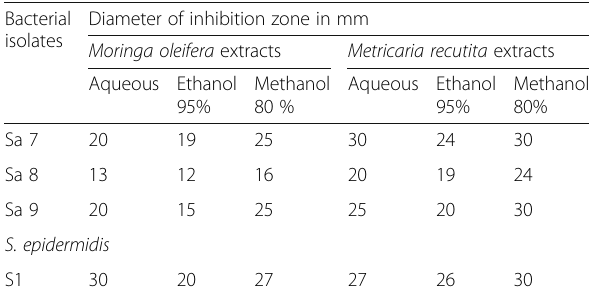
Table 5 Antimicrobial activity (in mm) of plant extracts against tested bacterial isolates (Continued) Bacterial Diameter of inhibition zone in isolates